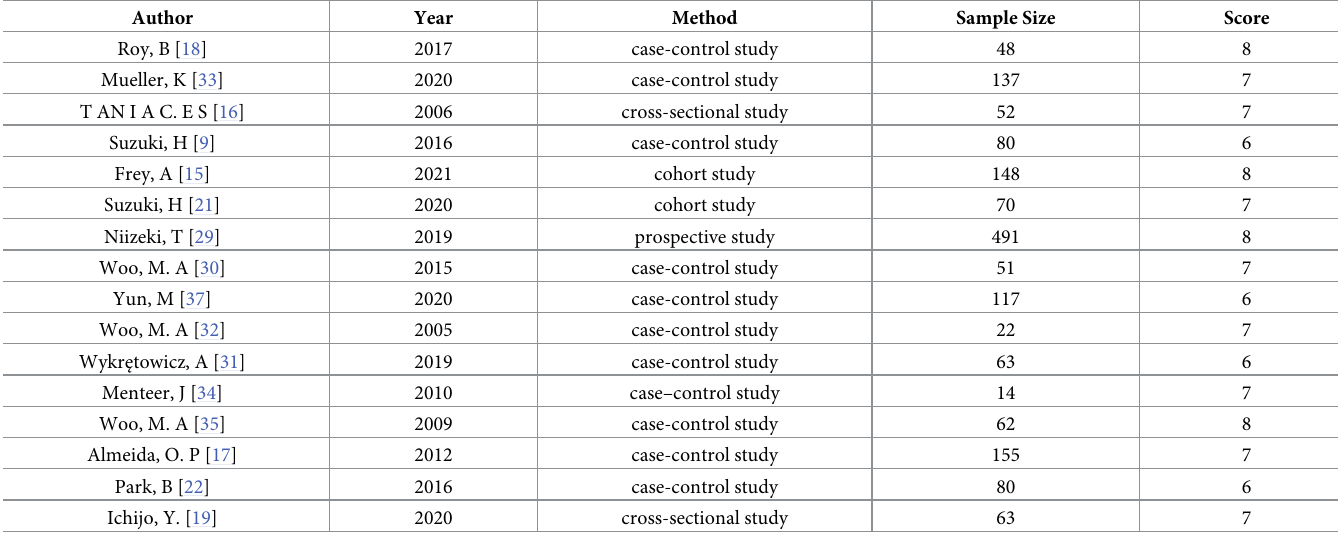
Table 3. Newcastle–Ottawa Scale (NOS) of included clinical studies.